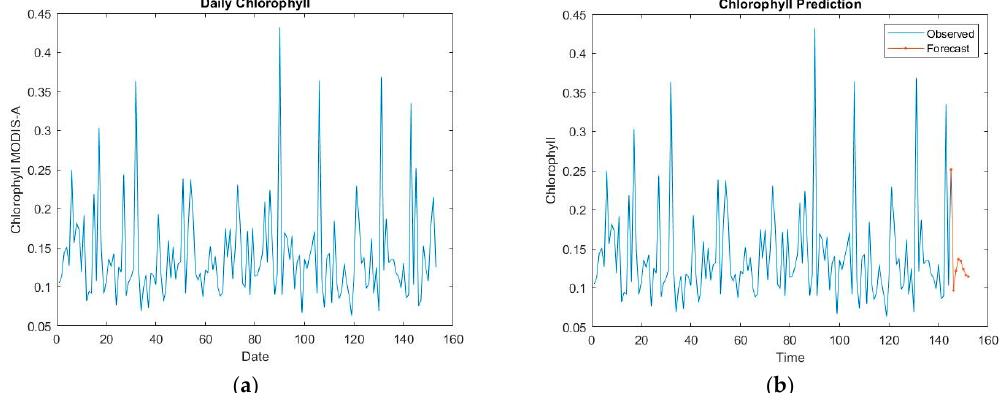
Figure 9. Chlorophyll time series forecasting ( a ) original times series, ( b ) time series with forecasted values.